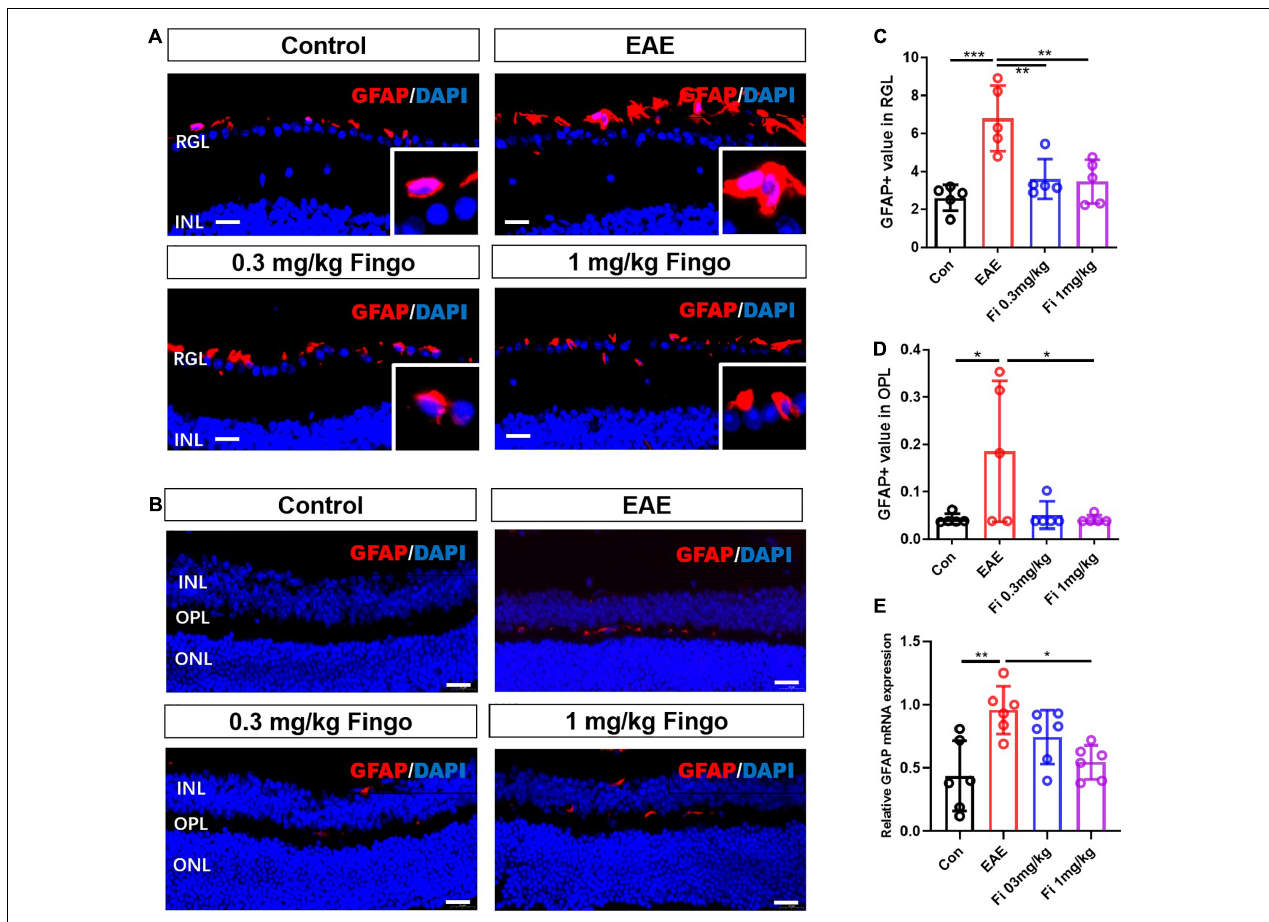
FIGURE 7 | Morphological and mean gray value changes of the GFAP+ cells in the retina. (A) GFAP antibody was used to label astrocytes in the retina. GFAP+ cells were primarily located in the RGL, and the cell body was hypertrophied in the EAE mice. (B) Comparisons of the GFAP mean gray value among groups in RGL. (C) . GFAP+ cells were slightly located in the OPL. (D) Comparisons of the GFAP mean gray value among the groups in OPL. (E) GFAP mRNA expression in retina. RGL, retinal ganglion layer; INL, inner nuclear layer; OPL, outer plexiform layer; ONL, outer nuclear layer. Values are represented mean ± SD. One-way ANOVA plus Tukey’s multiple comparisons. * P < 0.05, ** P < 0.01. Scale bar = 20 µ m.